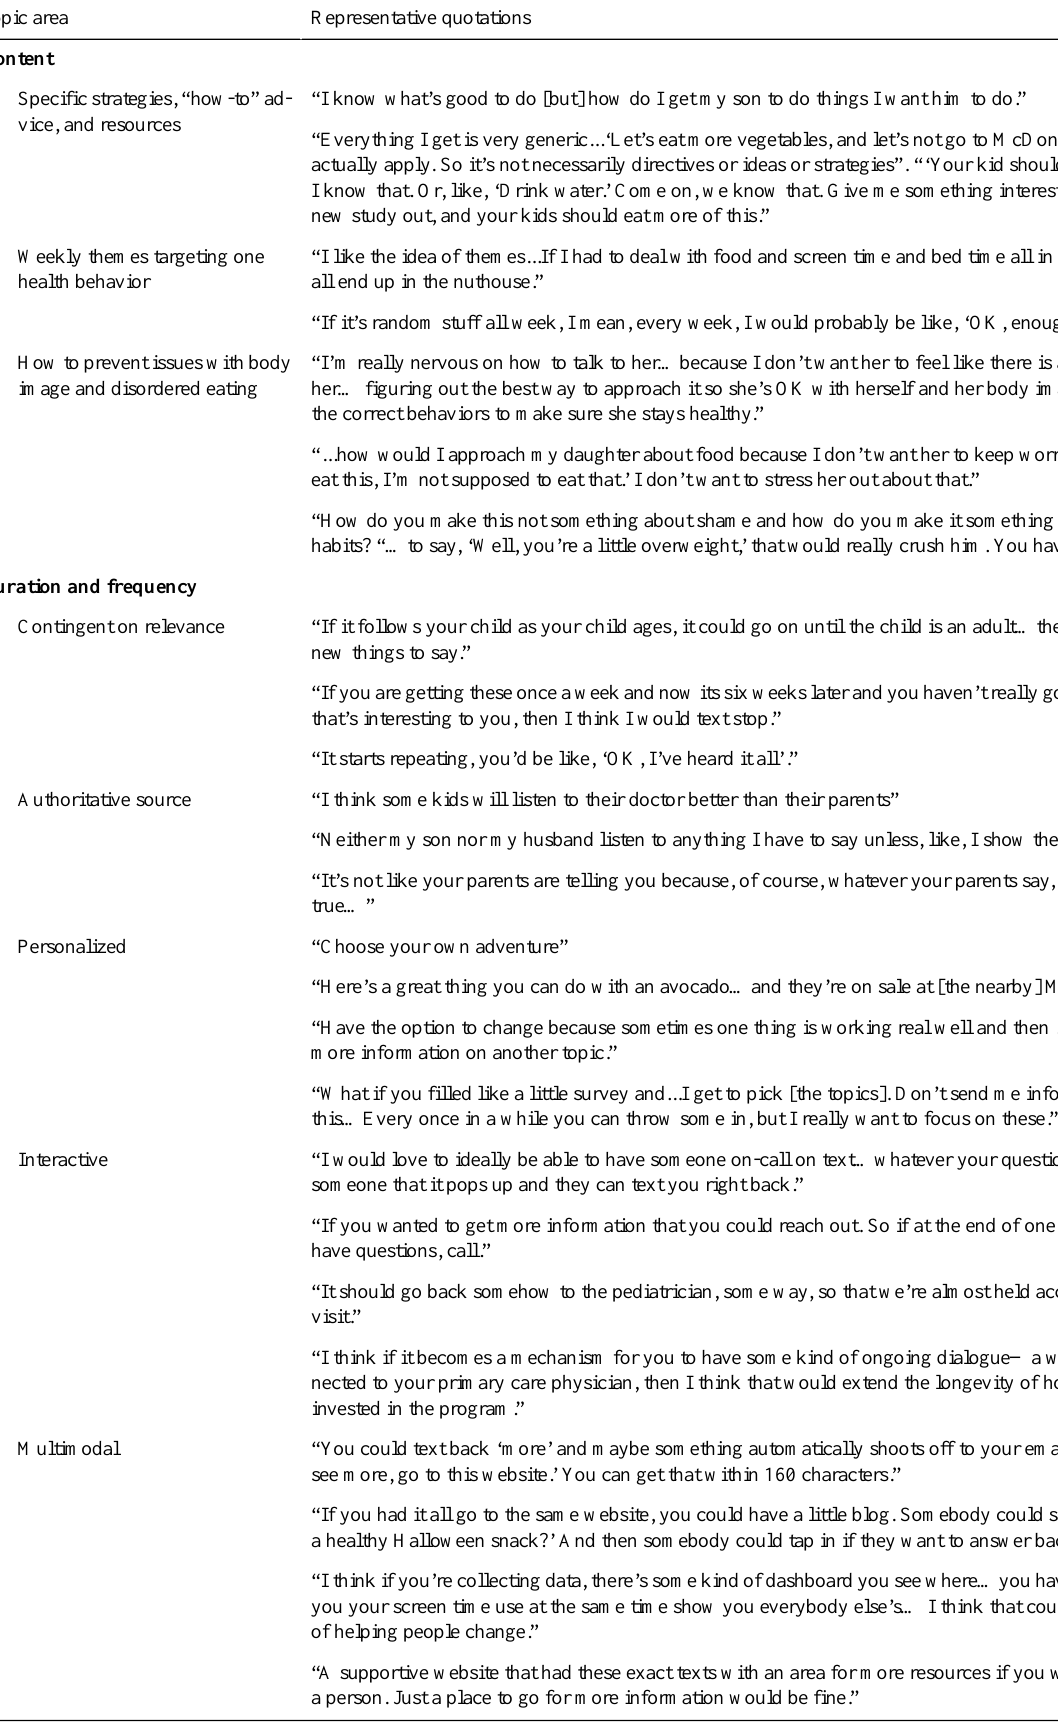
Table 3. Parent preferences for text messaging interventions to support child behavior change.